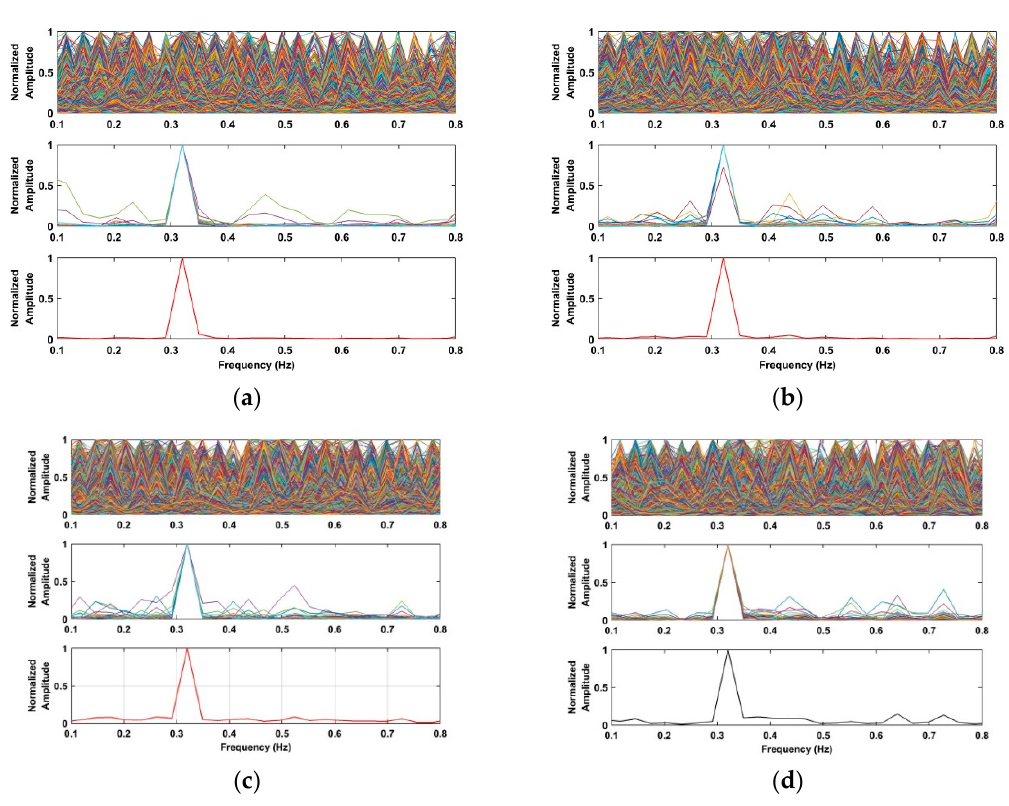
Figure 16 . Frequency estimates of the used actuator based on the acquired data at distances of ( a ) 4 m; ( b ) 7 m; ( c ) 10 m; and ( d ) 12 m indoors.